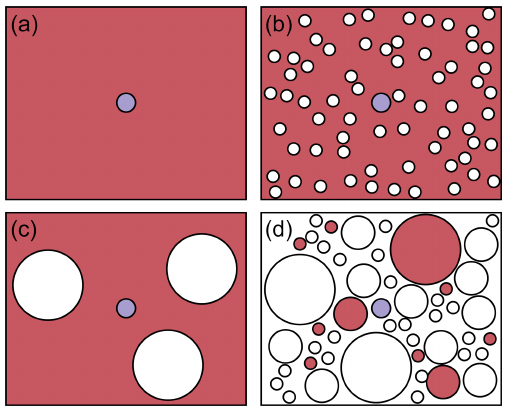
Figure 1. Schematic illustration of some idealised sediments dis- cussed in Sect. 2. Red indicates a source region or grain, blue indi- cates a dosimeter grain, and white indicates a grain or region of no